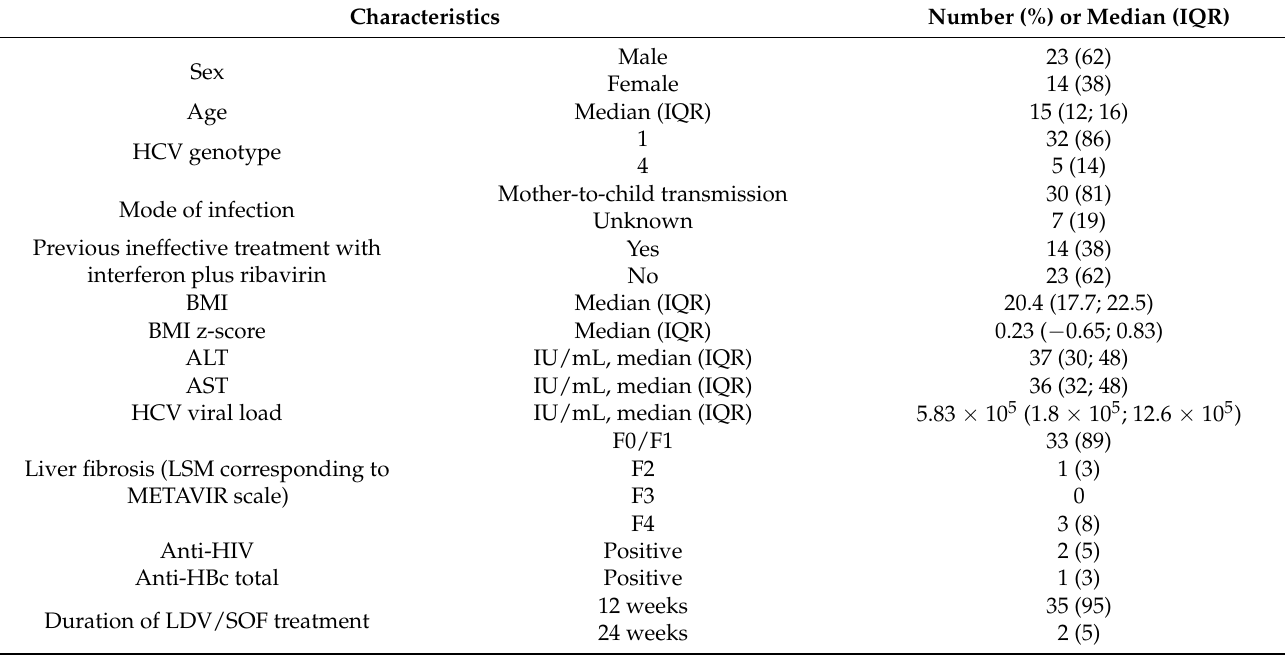
Table 1. Baseline characteristics of 37 patients with chronic HCV infection treated with ledipasvir/sofosbuvir (LDV/SOF).